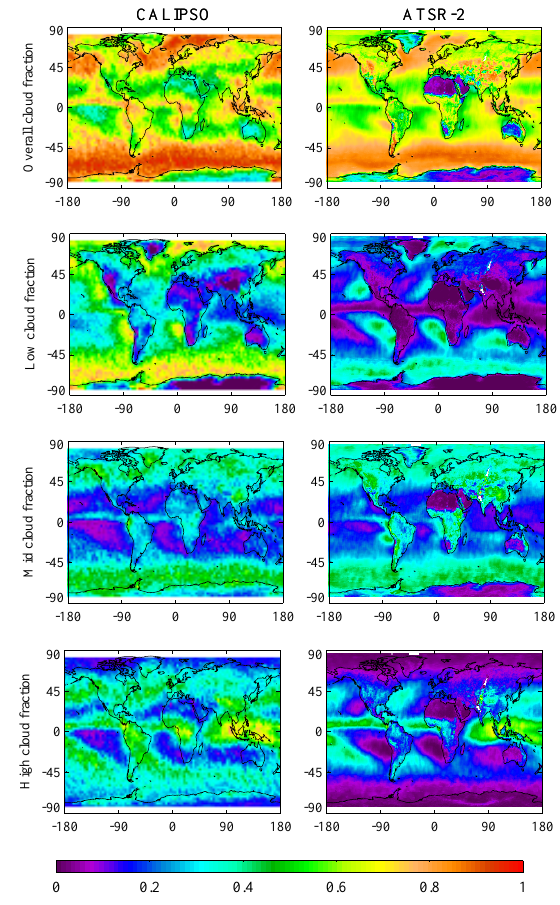
Fig. 11. Multiyear composites of fractional cover of (top-bottom) any, low (CTP > 680hPa), mid-level (680hPa ≥ CTP ≥ 440hPa), and high (CTP < 440hPa), from the CALIPSO-GOCCP (left) and ATSR-2 GRAPE (right)